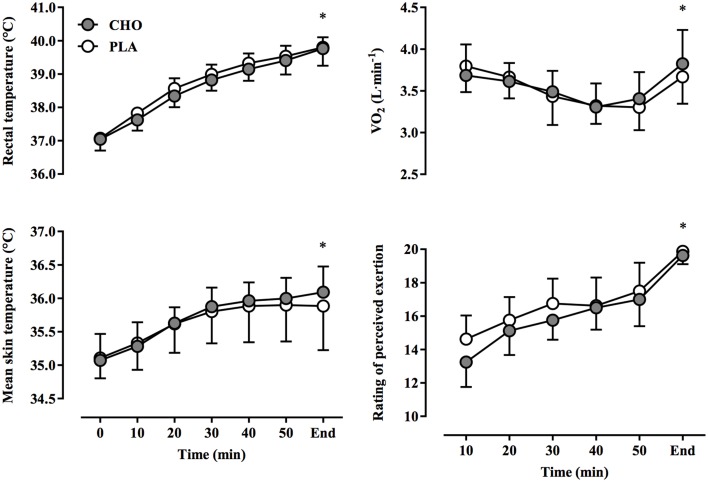
Rectal and mean skin temperatures, rate of oxygen uptake (VO2), and ratings of perceived exertion (RPE) at 10-min intervals and at the end of exercise during a 40-km cycling time trial in hot and humid conditions while rinsing the oral cavity with a carbohydrate solution (CHO) or taste- and color-matched placebo (PLA). No significant treatment-by-time interaction was observed; * indicates main effect of time (P < 0.01).